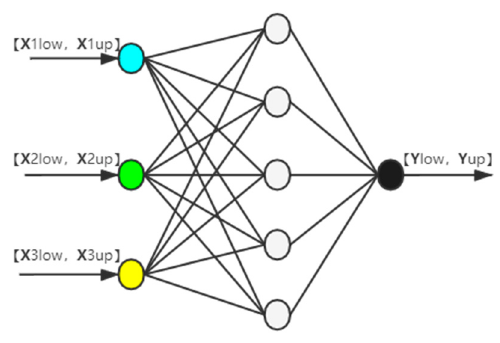
Figure 2. A neural network with interval input space.